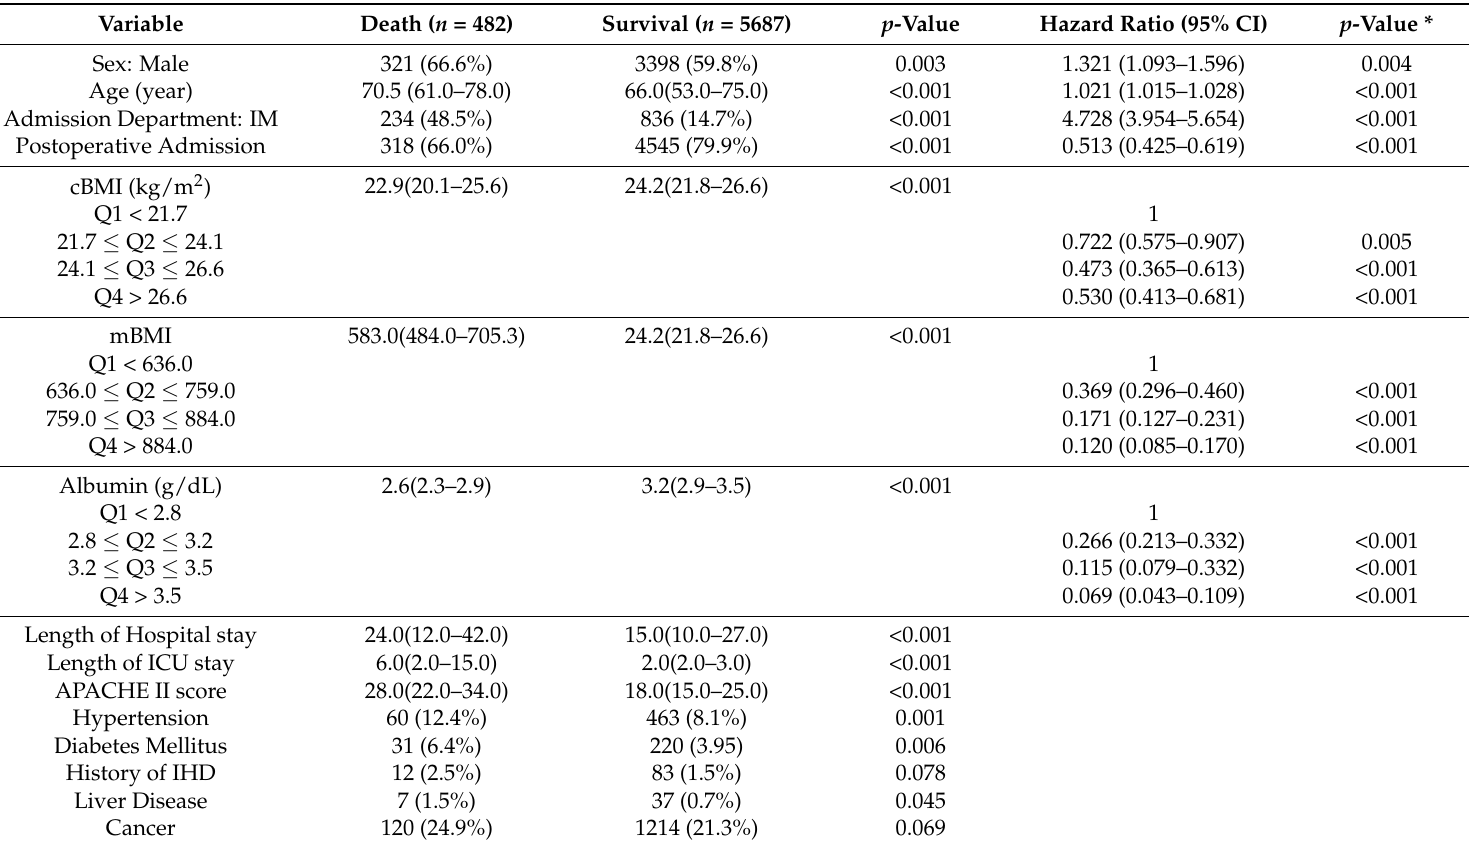
Table A1. Univariate Cox Regression Analysis for 30 day Mortality after ICU